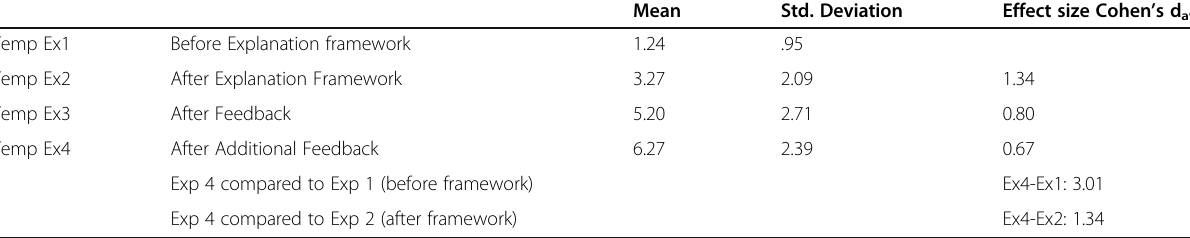
Table 5 Student Temperature science ideas across an evolving explanation ( n = 51)*